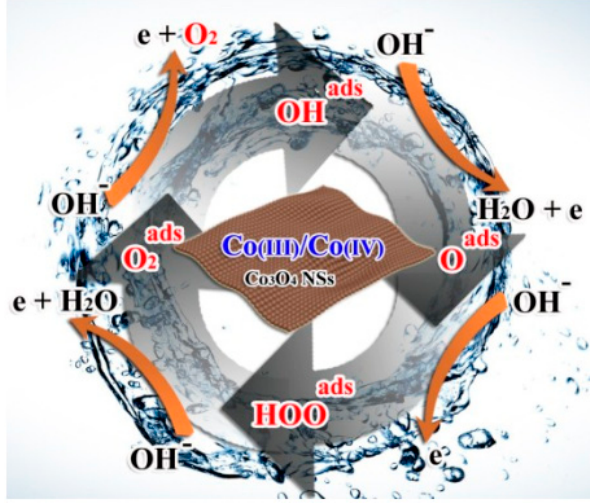
Figure 13. The scheme exemplifying the proposed OER electrocatalytic mechanism on Co 3 O 4 NSs. Reproduced from [142], Copyright © Royal Society of Chemistry,